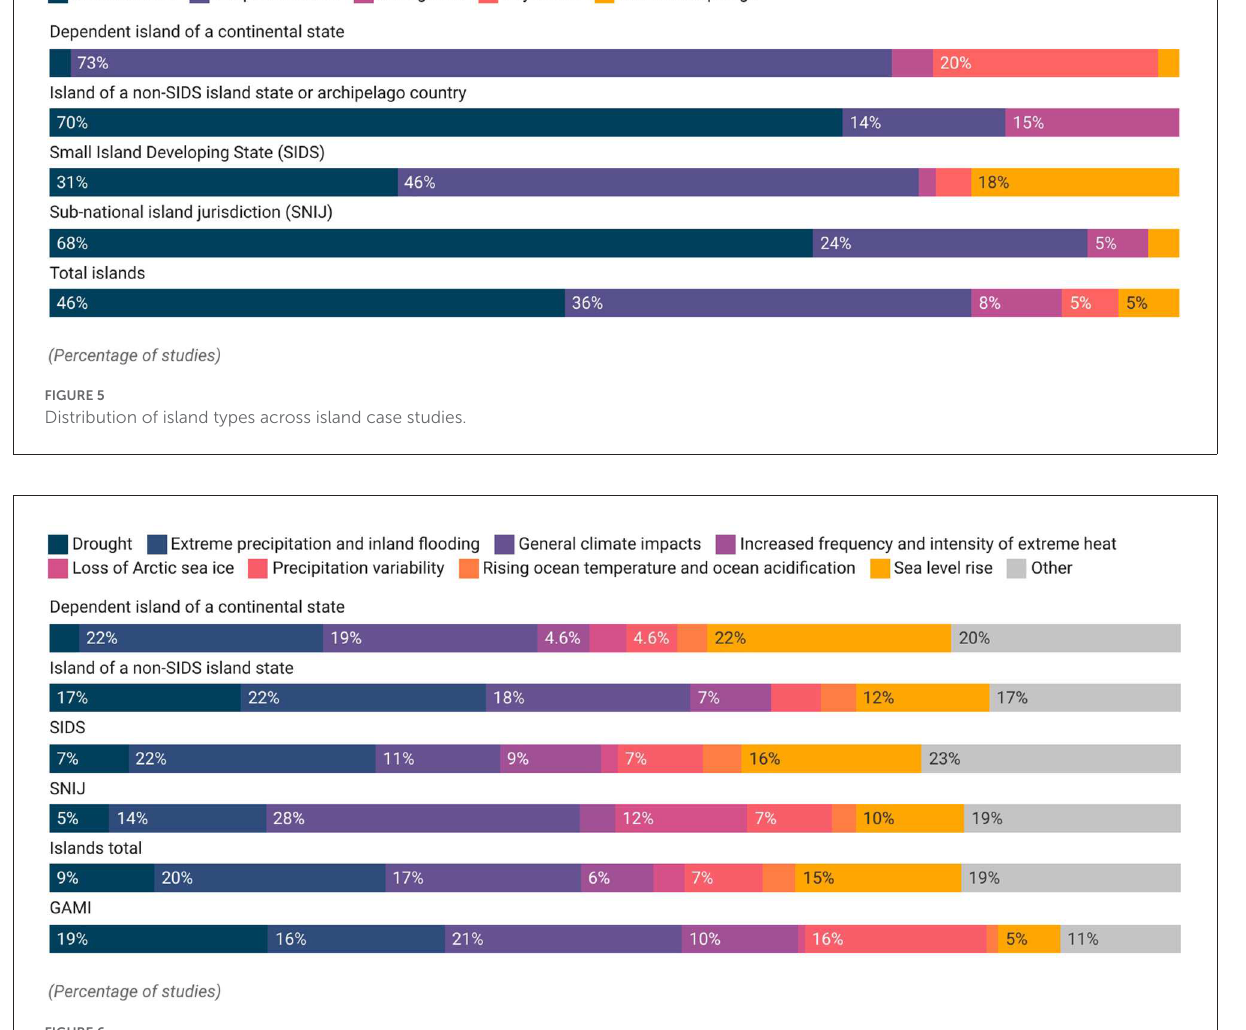
FIGURE6 Distribution of hazards reported in island case studies compared to the whole GAMI